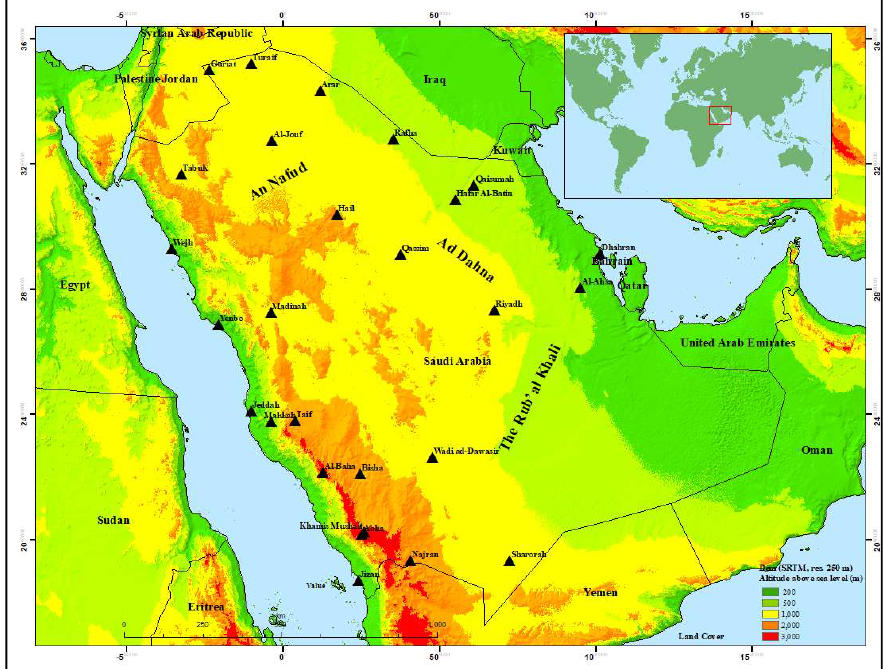
Figure 1. Elevation map of the Arabian Peninsula with annotation of major cities and deserts, as well as the location of the in situ dust storm measurement stations.